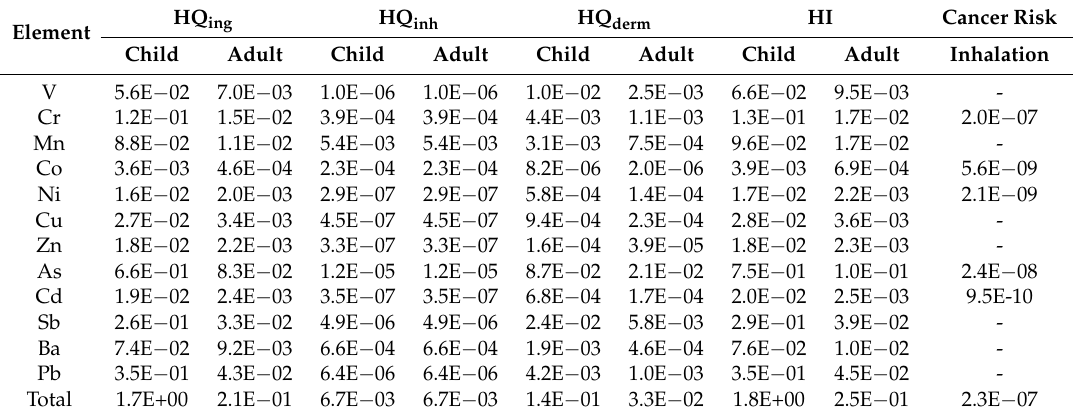
Table 4. Hazard quotients (HQs) and hazard indexes (HIs) of potentially toxic elements in settled dust for children and adults through the three pathways in Beijing urban area. Besides, cancer risks of Cr, Co, Ni, As, and Cd via inhalation are also